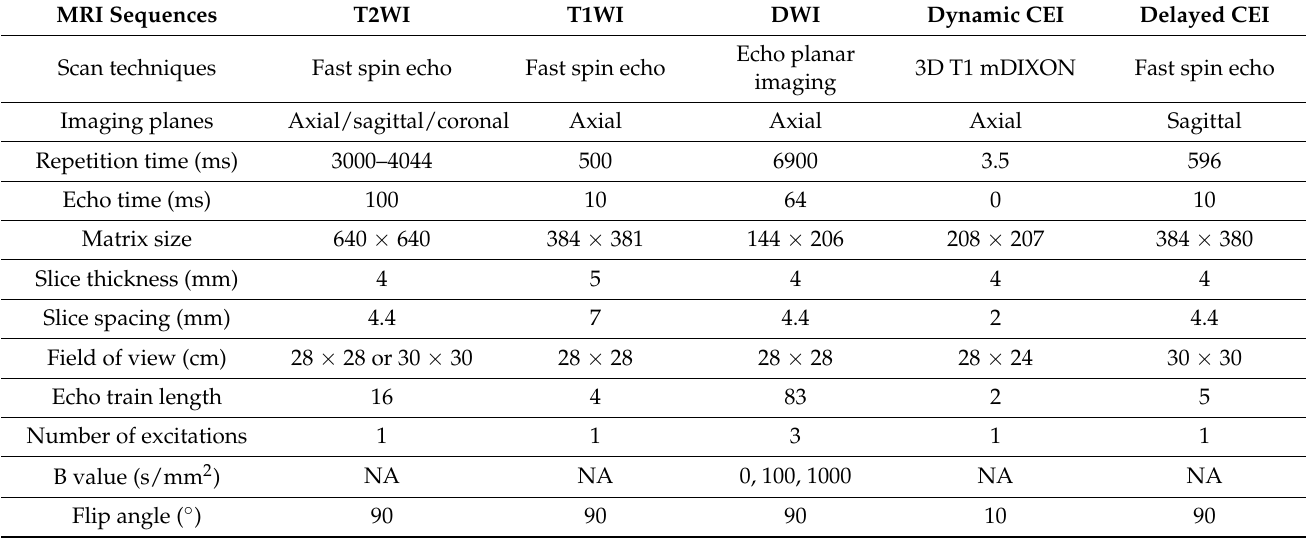
Table 1. Samsung Medical Center parameters for 3T MRI of cervical